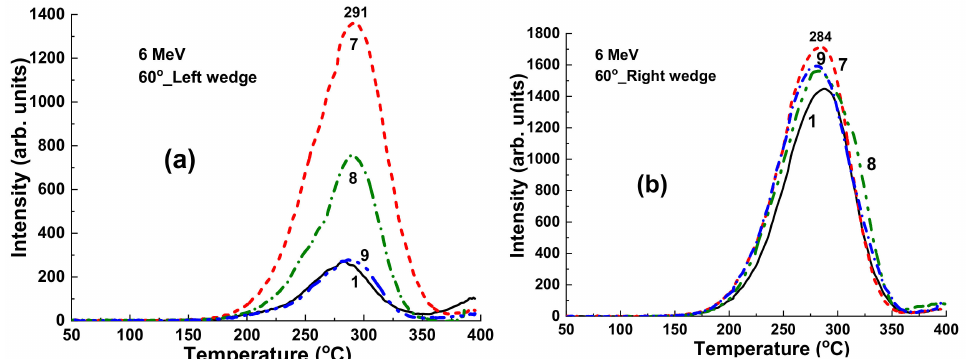
Figure 11. ( a ) TSL glow curves for YAG:Ce crystal samples irradiated by 6 MV X-ray photons from Clinac 2300 accelerator in the case of using additional 60 ◦ _Left ( a ) and 60 ◦ _Right ( b ) wedges (see Figure